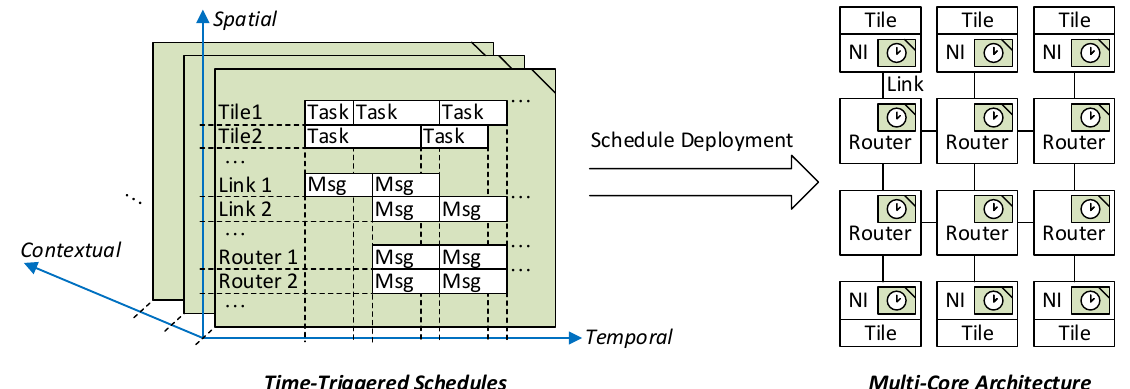
Figure 1. Deployment of time-triggered schedules ( left ) on the building blocks of the ATMA, such as NIs and routers ( right